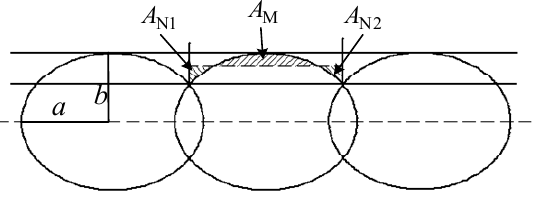
Figure 6. SRVF-LB model schematic.